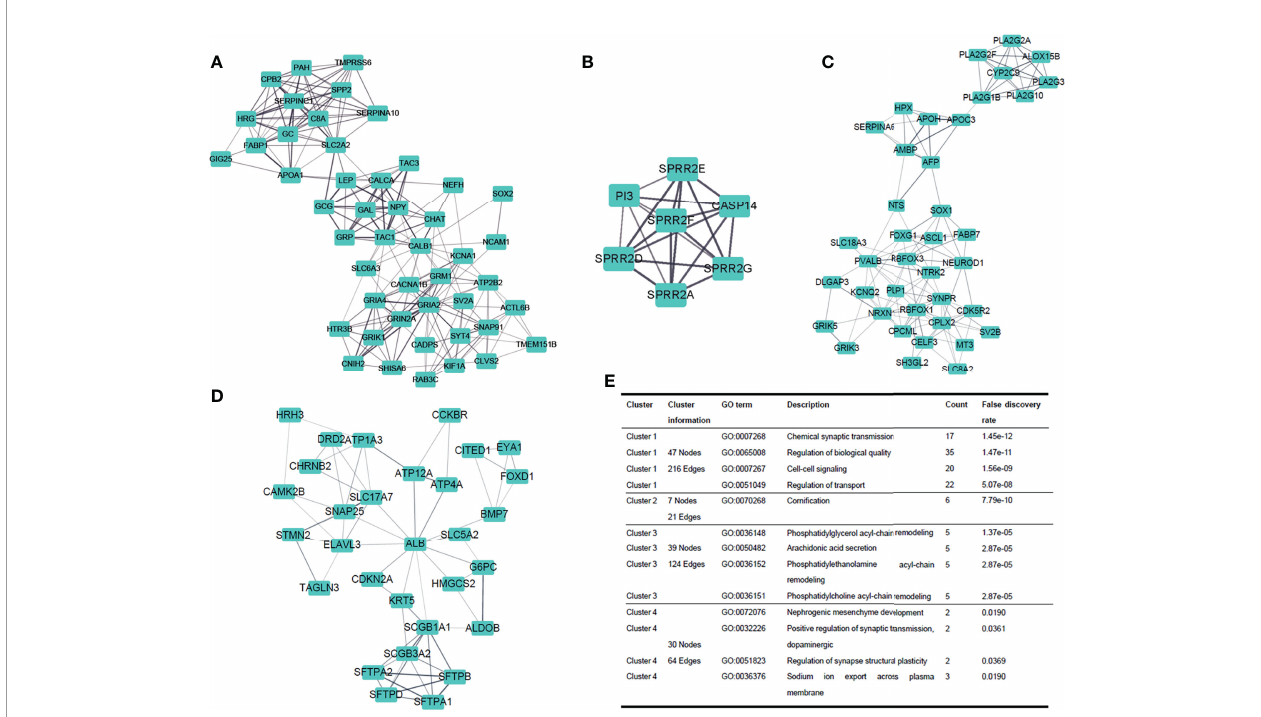
FIGURE 5 | Dissection of protein-to-protein interaction. (A – D) Top four clusters in the protein-to-protein interaction (PPI) network. Line thickness indicates the strength of data support. (E) GO enrichment analysis of the four clusters,